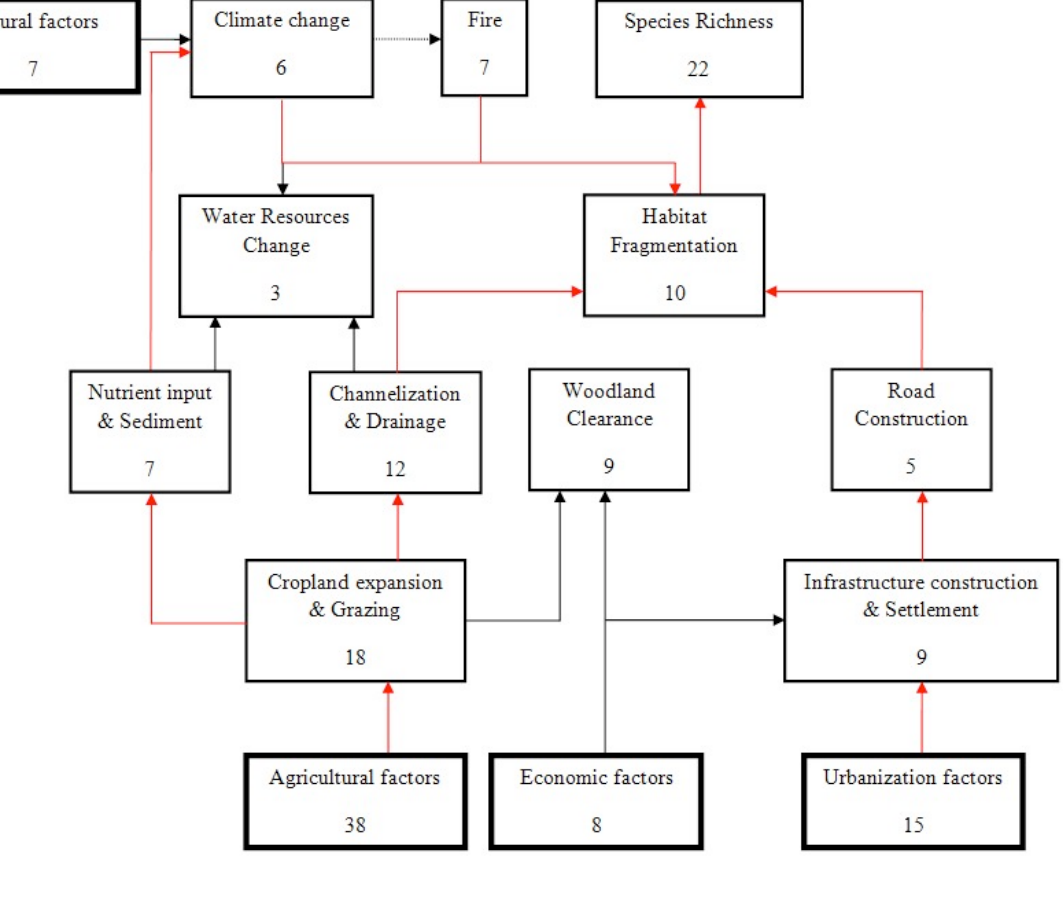
Figure 3. Critical path of wetland loss based on driving forces. Thirty-eight studies support the impact of agricultural factors on wetlands. Furthermore, 18 studies agree that cropland expansion and grazing are contributing factors to wetland change. Proximate causes forge connections (all black and red lines) to transmit the power of wetland loss based on underlying causes. The end rectangles, such as Species Richness, are such